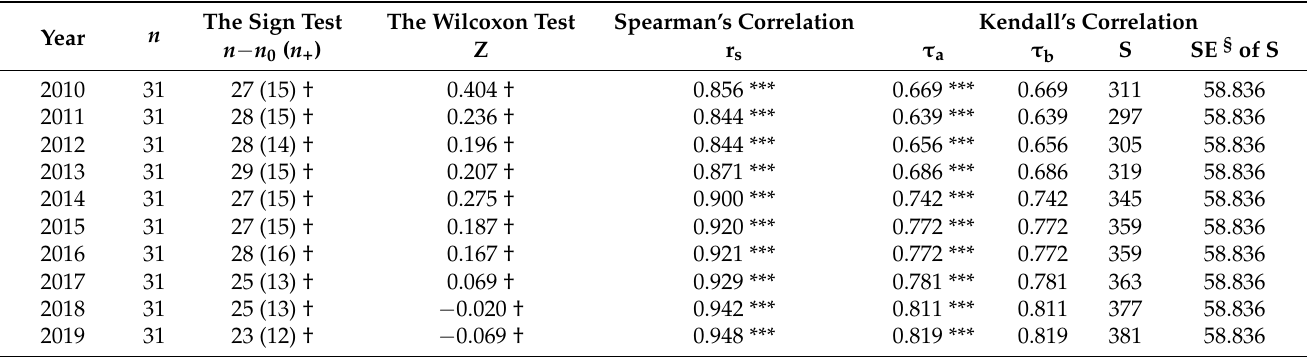
Table 9. Results of the sign test, the Wilcoxon test and Spearman’s and Kendall’s correlation tests for DALY ranks for the total population and the older subpopulation in 2010–2019.